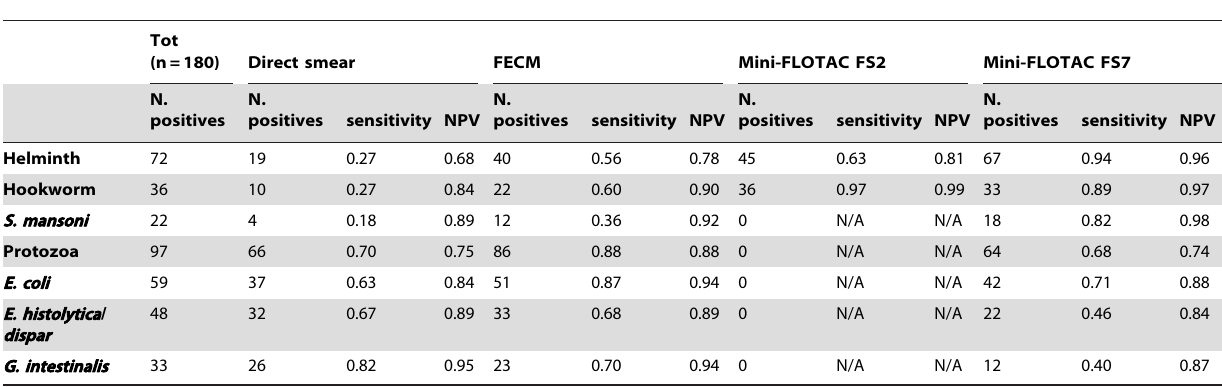
Table 1. Sensitivity and negative predictive value (NPV) of each diagnostic method.